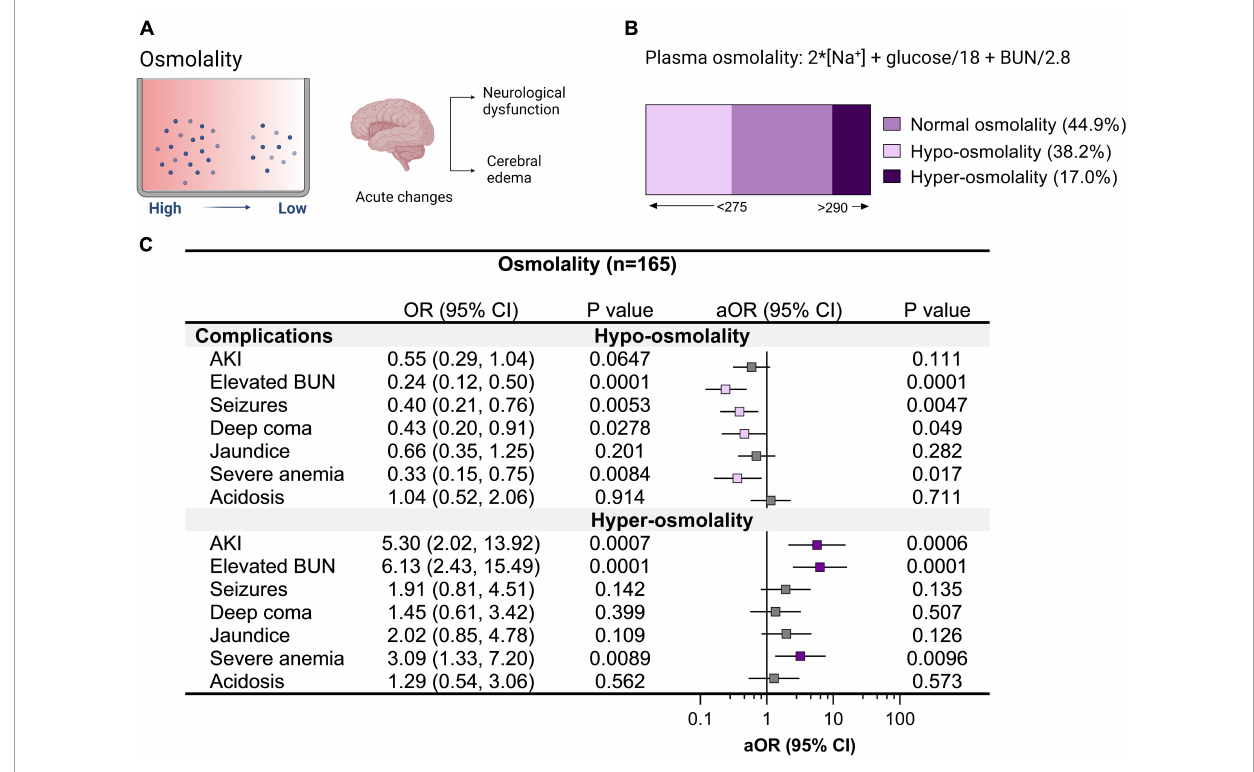
FIGURE4 Relationship between clinical complications and altered plasma osmolality in cerebral malaria. (A) Plasma osmolality reflects the body’s water and electrolyte balance. The brain is sensitive to changes in plasma osmolality with acute changes in hypoosmolality linked with neurological complications and cerebral edema. (B) Plasma osmolality was assessed in children with cerebral malaria and categorized into hypo-osmolality ( < 275) and hyper-osmolality ( > 290) on admission to hospital using serum sodium, glucose, and blood urea nitrogen (BUN). (C) Forest plot showing the relationship between clinical complications and changes in osmolality using logistic regression depicting the odds ratio (OR) and adjusted OR (aOR) adjusting for child age and